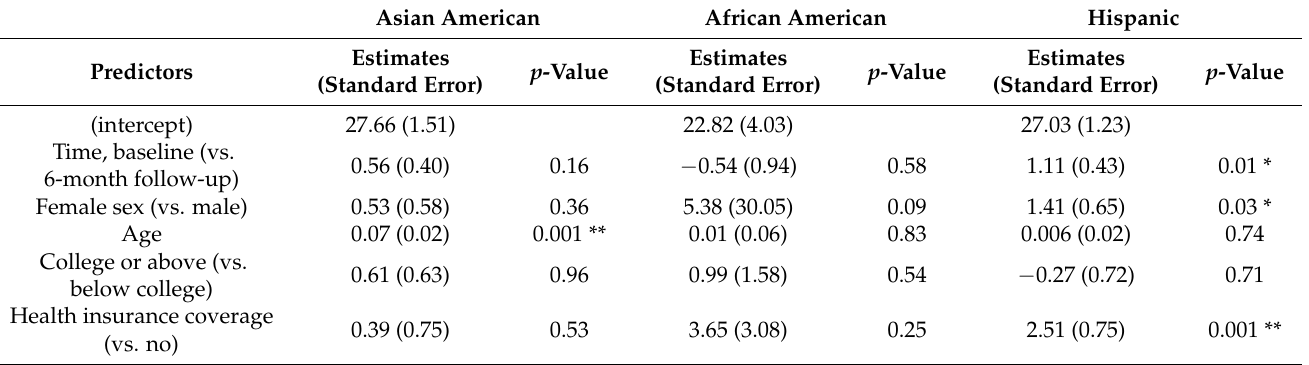
Table 3. Fixed effect estimates of the linear Mixed-effects model analysis of the Mediterranean diet score among the Hispanic subsample (N = 139). Asian American African American